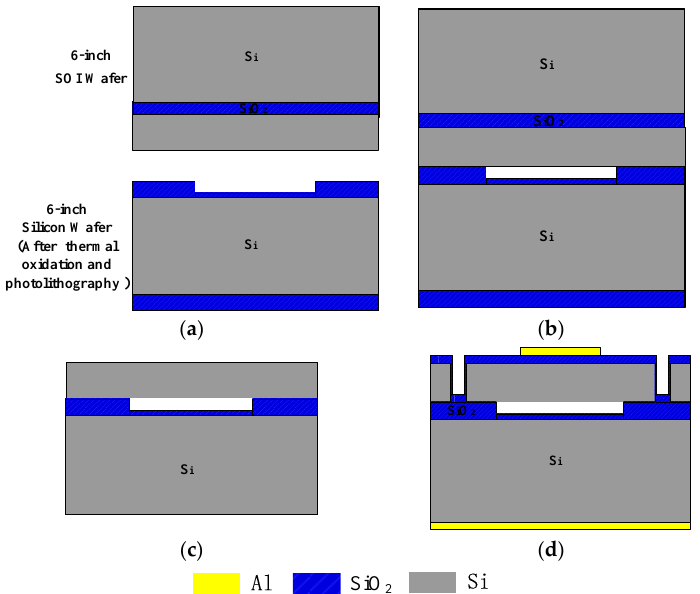
Figure 3. The main fabrication flow-charts. ( a ) part etched to form cavities; ( b ) bonding; ( c ) form membrane; ( d ) form isolation channel, insulation layer and electrodes.